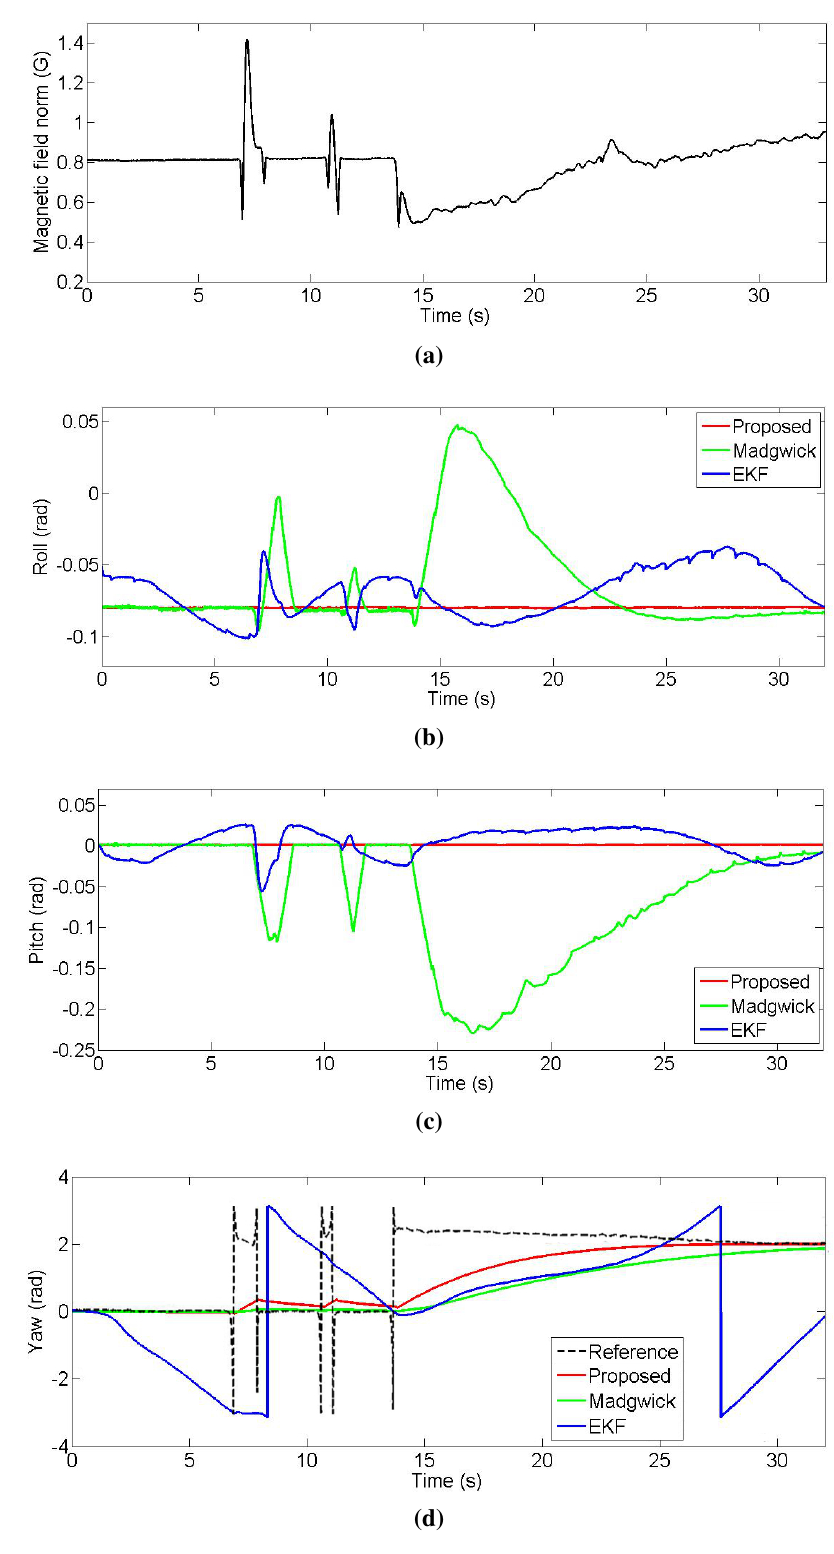
Figure 8. Comparison of the different estimation methods in the presence of magnetic disturbances. ( a ) Norm of the measured magnetic field vector; ( b ) Roll; ( c ) Pitch; ( d )